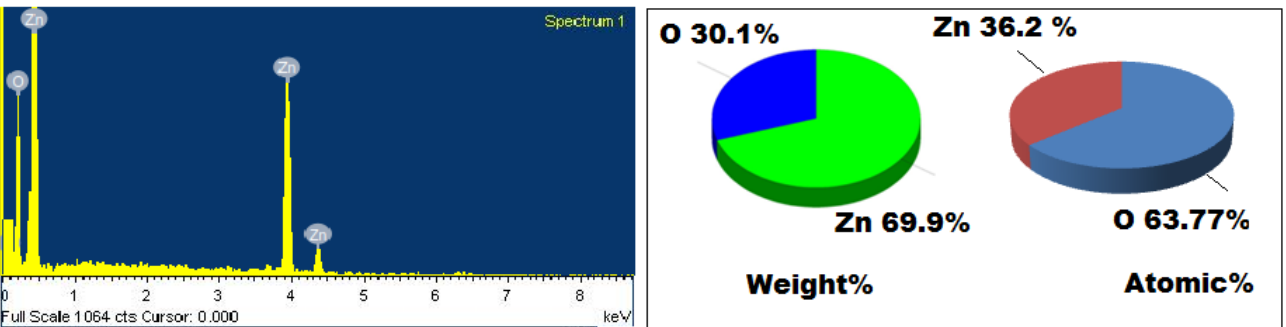
Figure 4. EDX spectrum of ZnONPs synthesized using oat biomass. Weight % of Zn, 69.9%; O, 30.1%. Atomic % of Zn, 36.2%; O, 63.77%.